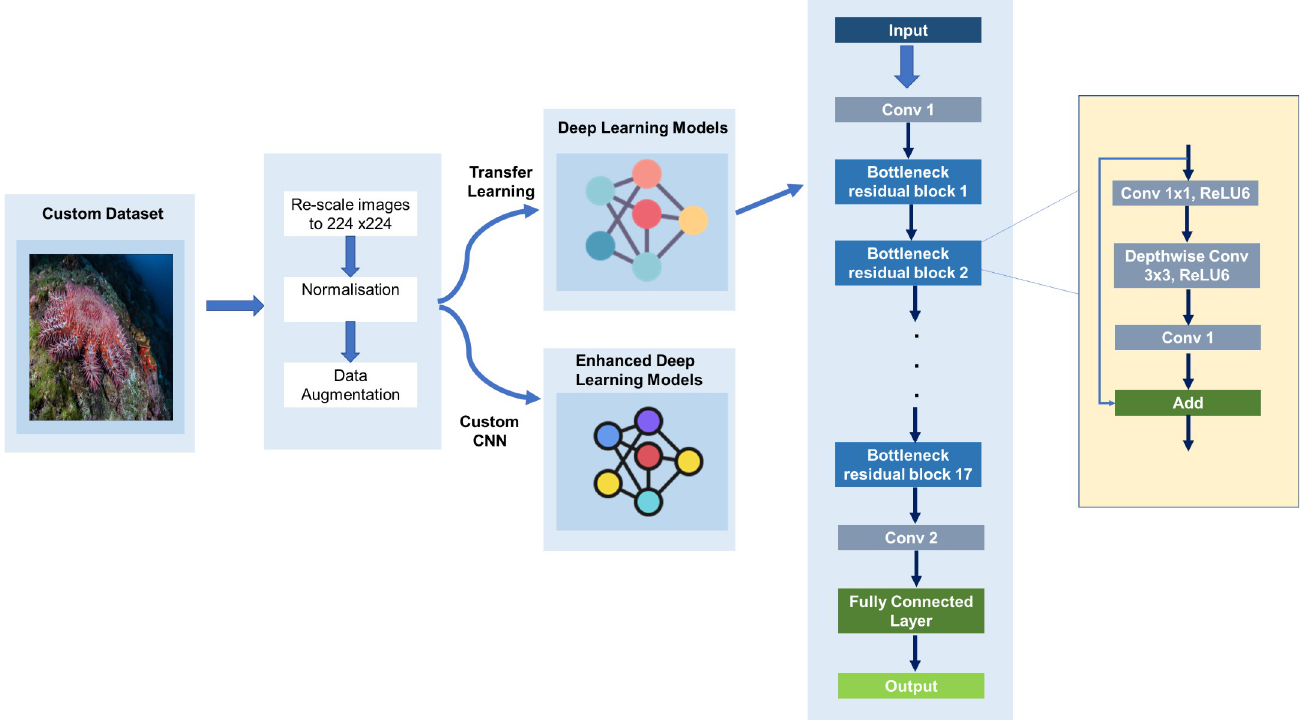
Fig 6. System architecture with MobileNetV2